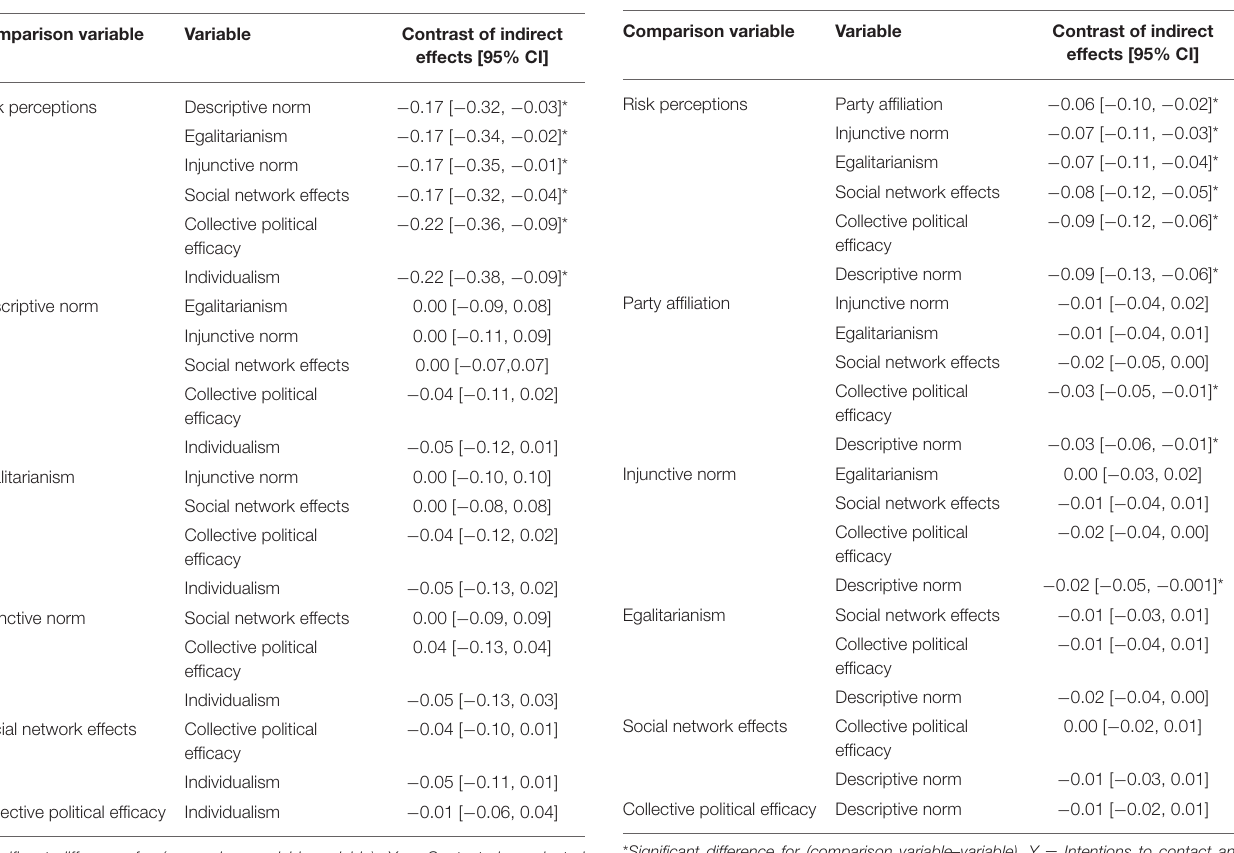
TABLE 7 | Competitive mediation analysis of intentions to contact a government official between Latinos and